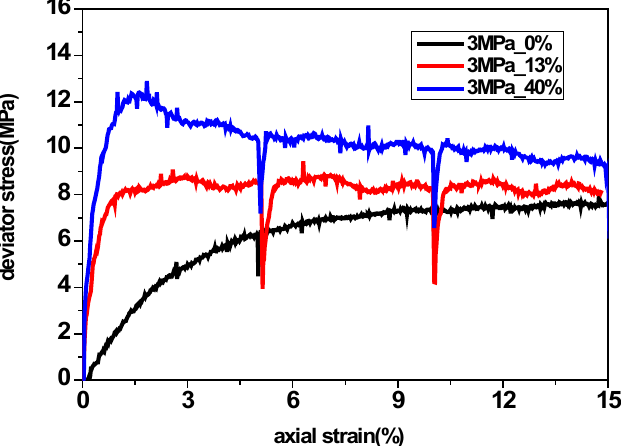
Figure 9. Stress–strain curves under different hydrate saturation ( σ 3 = 3MPa).